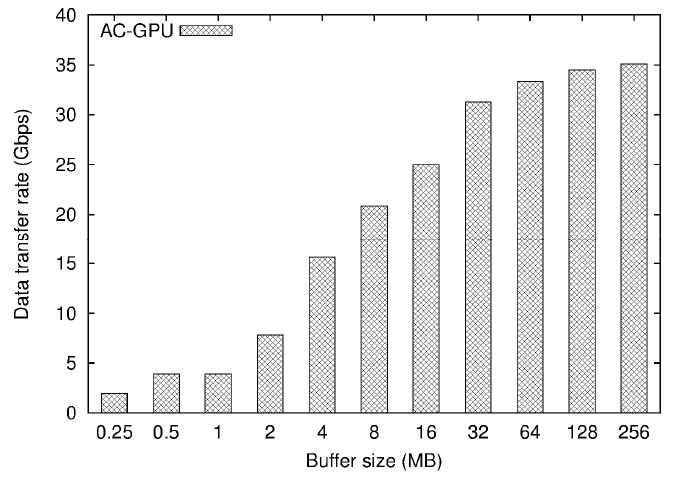
Figure 4. The data transfer rate between CPUs and GPUs with different full matching buffer sizes.